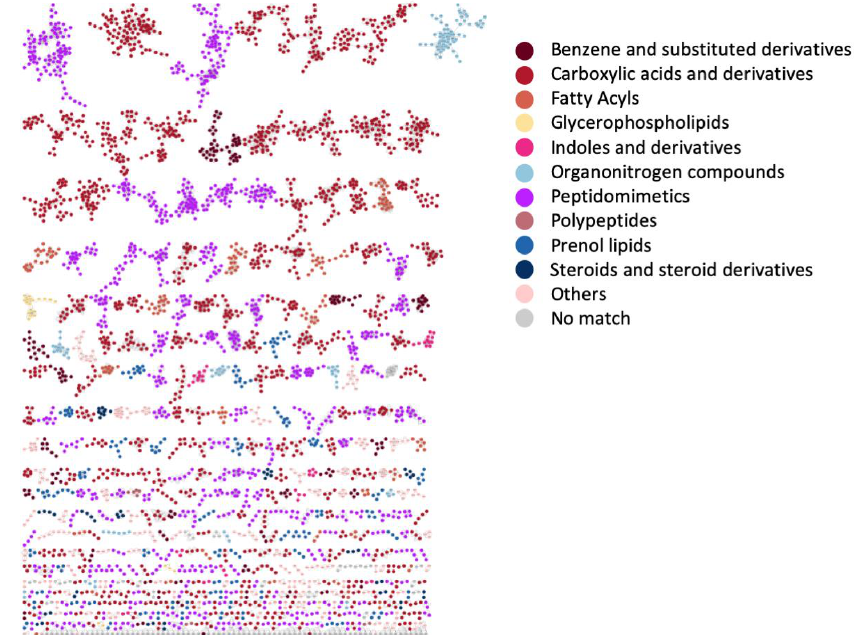
Figure 7. Nematode symbionts Photorhabdus / Xenorhabdus network colored by 10 selected chemical class terms as indicated in the legend. In total, 49 different class terms were annotated in the network using MolNetEnhancer. We can observe that the larger molecular families as well as many smaller molecular families are mostly annotated with peptidomimetics (purple) and carboxylic acids and derivatives (red). This is consistent with earlier findings that these nematode symbionts produce a wide array of peptidic products.